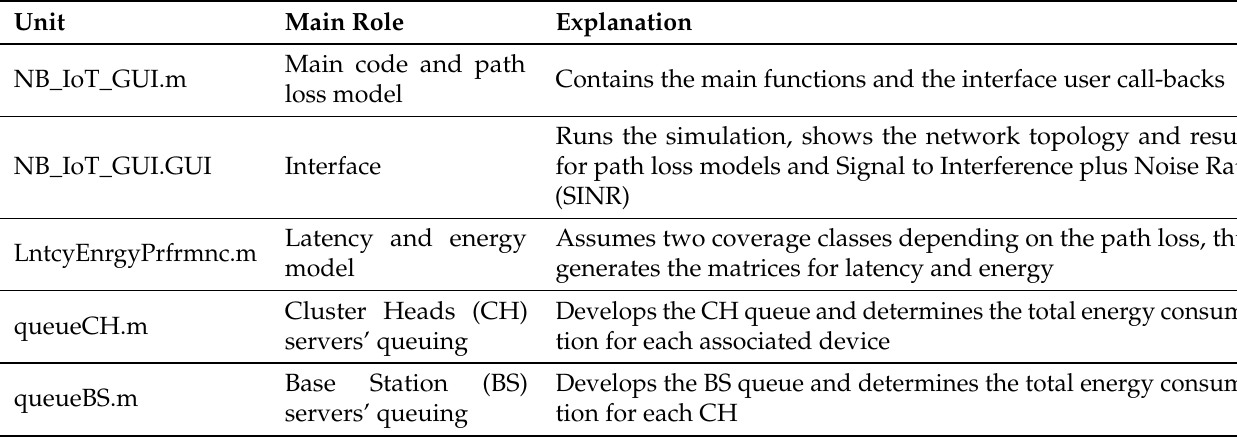
Table 1. MATLAB-based Narrowband-Internet of Things (NB-IoT) Device-to-Device (D2D) simulation framework: Key